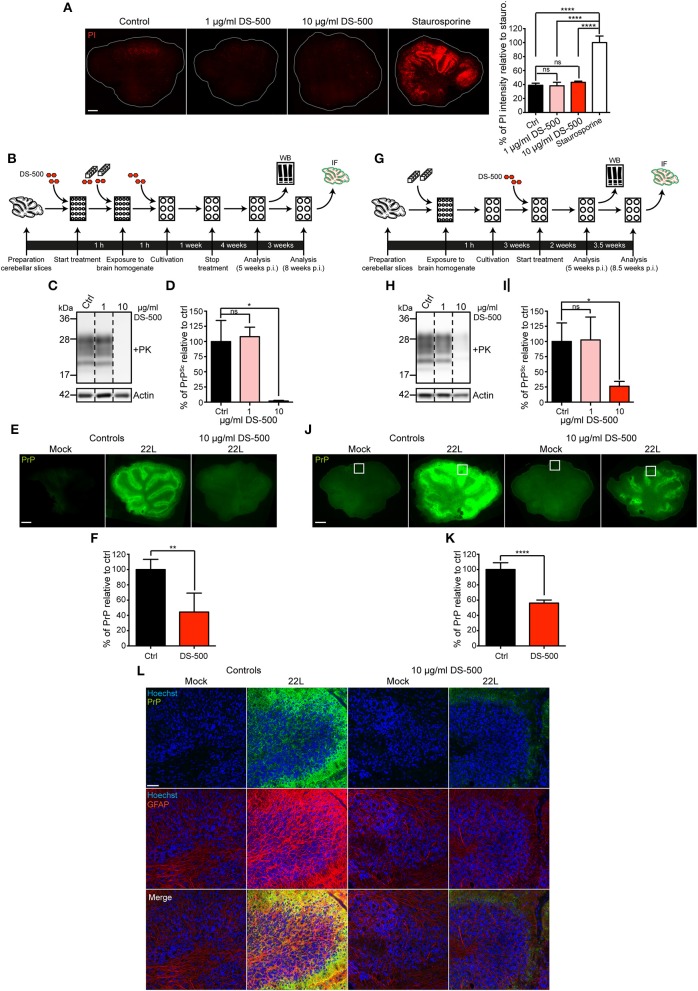
Anti-prion compound DS-500 reduces abnormal prion protein deposition. (A) Viability of slices cultured in the presence or absence of different concentrations of DS-500. Slices were cultured for 1 week, then 1–10 μg/ml DS-500 were added for 5 weeks. Slices were subsequently stained for dead cells using propidium iodide (PI). Slices treated with 5 μM staurosporine served as positive controls. Samples were analyzed by epifluorescence microscopy using the tile scanning function with identical imaging settings. Scale bar: 500 μm. Statistical analysis was performed using One-way ANOVA with Tukey's multiple comparisons test. Asterisks indicate significant changes (n = 3; ****p < 0.0001; ns, not significant). (B) Experimental setup to study the effect of DS-500 on the establishment of a 22L prion infection in cerebellar slices. Cerebellar slices were pretreated with different concentrations of DS-500 for 1 h and exposed to inoculum in the presence of DS-500 for 1 h. Slices were maintained in medium containing DS-500 for 1 week. Slices were kept in normal medium for up to 8 weeks p.i. (C) Cerebellar slices were lysed at week 5 p.i. and lysates were proteinase K-digested. MAb 4H11 was used to analyze PK-resistant PrP (PrPSc) by western blot. Actin was detected as a loading control in –PK samples. Mock treated slices served as controls. For presentation purposes additional lanes were excised. (D) Statistical analysis of PrPSc levels detected by western blot. Bars represent mean values ± SD (n = 5). Statistical analysis was performed using One-way ANOVA with Dunnett's multiple comparisons test. Asterisks indicate significant changes in the mean values of DS-500 treated samples relative to control samples set to 100% (*p < 0.05; ns, not significant). (E) Specific detection of PrPd following antigen denaturation (green). Samples were analyzed by epifluorescence microscopy using the tile scanning function with identical imaging settings. Scale bar: 500 μm. (F) PrPd intensity of 22L infected slices treated with 10 μg/ml DS-500 was quantified relative to 22L infected control slices set to 100%. Bars represent mean values ± SD (n = 4). Statistical analysis was performed using unpaired two-tailed t-test (**p < 0.01; ns, not significant). (G) Experimental setup to study the effect of DS-500 on persistent 22L prion infection in cerebellar slices. After exposure to inoculum for 1 h, slices were cultured with normal medium for 3 weeks. Subsequently, slices were cultured in the presence of DS-500 until 5 and 8.5 weeks p.i. (H) PK-resistant PrP (PrPSc) present in slices 5 weeks p.i. was detected by western blot using mAb 4H11. Actin was detected in -PK samples as loading control. For presentation purposes additional lanes were excised. No statistically significant changes in actin levels were observed between infected and uninfected slices (data not shown). (I) Quantitative comparison of PrPSc levels in prion-infected control slices and DS-500 treated, infected slices. The amount of PrPSc in the 22L infected control slices was set to 100% and was compared to the amount of PrPSc in the DS-500 treated, infected slices. Bars represent mean values ± SD (n = 3; *p < 0.05; ns, not significant). (J) Detection of PrPd 8.5 weeks p.i. following antigen denaturation. Samples were analyzed by epifluorescence microscopy using tile scanning function with identical imaging settings. Scale bar: 500 μm. Shown are prion infected and Mock exposed slices that were/were not treated with 10 μg/ml DS-500 for 5.5 weeks. The boxed region was chosen for confocal microscopy analysis in (L). (K) PrPd intensity of 22L infected slices treated with 10 μg/ml DS-500 for 5.5 weeks was quantified relative to 22L infected control slices set to 100%. Bars represent mean values ± SD (n > 4, ****p < 0.0001). (L) Molecular and Purkinje cell layers of folia VII (boxed area in J) were imaged by confocal microscopy using the tile scanning function with identical imaging settings for each sample group. PAb anti-GFAP was used to stain astrocytes (red). PrPd was detected with mAb 4H11 (green). Nuclei were counterstained with Hoechst. Scale bar: 50 μm. WB, western blot; IF, immunofluorescence.